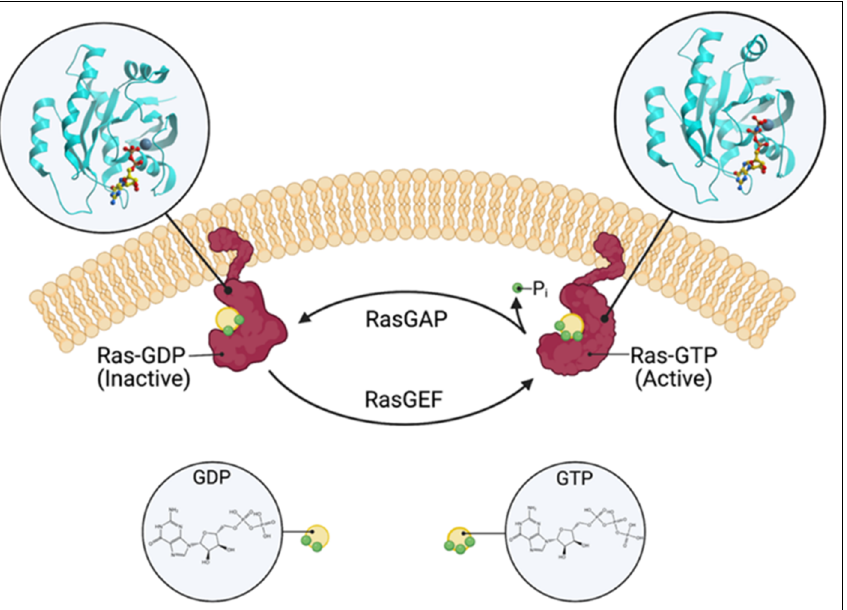
Figure 1. Schematic of the Ras switching cycle. Ras cycles between the GTP-bound active state and the GDP-bound inactive state. RasGAP catalyzes the hydrolysis of GTP, and RasGEF facilitates guanine nucleotide exchange. Created with BioRender.com.